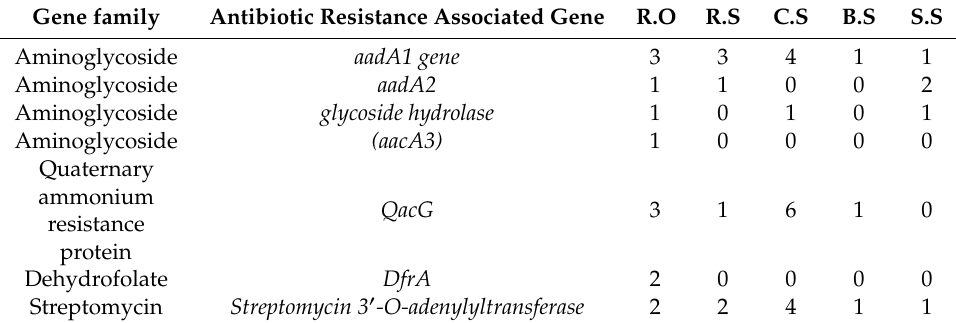
Table 2. Clone numbers of the antibiotic resistance GCs detected in all samples. Gene family Aminoglycoside